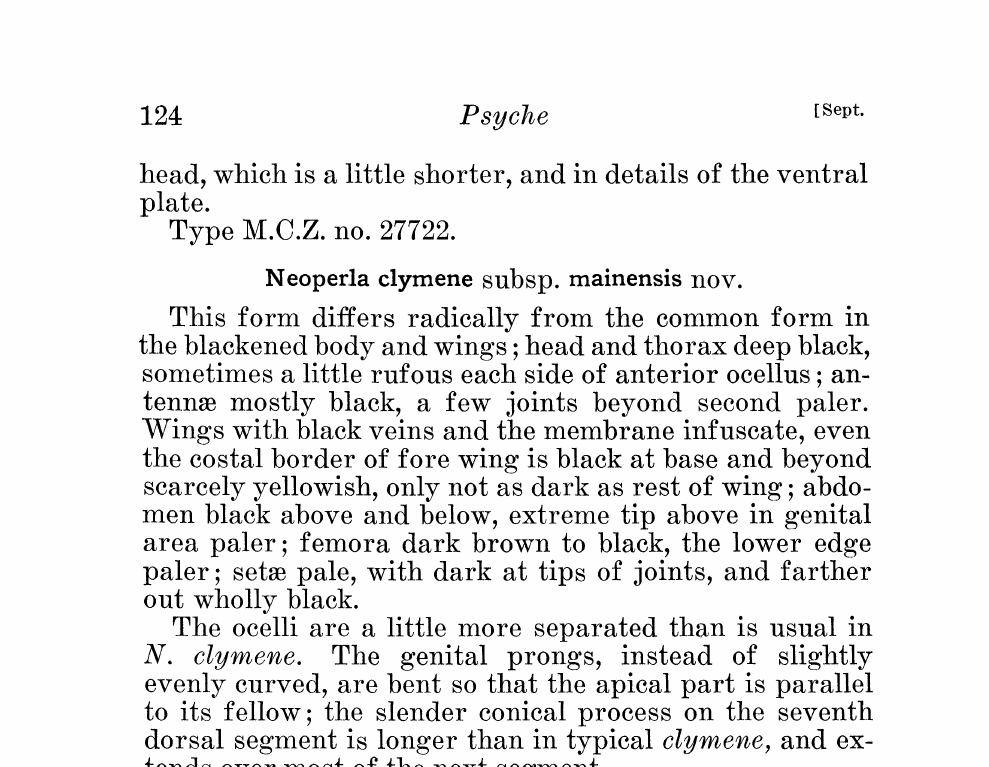
EXPLANATION OF [-)LATE 11 ig. 1. Perlesta decipiens, male genital prongs, and one from side. Fig. 2. Perlesta placida, male genital prongs, and one from side. ig. 3. Perlesta frisoni, female anal plates, and ocellus and boss. Fig. 4. Perlesta frisoni, male genital prongs. texana, tip of abdomen, ocelli, and hind tibia. Fig. 5. Perlesta Fig. 6. Perlesta cinctipes, tip of abdomen, seta, hind femur and tibia. Fig. 7. Perlesta brunneipennis, male genital prongs, and hind tibia. texana, male genital prongs. :Fig. 8. Perlesta Fig. 9. Perlesta cinctipes, male genital prongs. Fig. 10. Perlesta placida, tip of female abdomen from below. Fig. 11. Perlesta frisoni, subgenital plate of female, and ocellus and boss. Fig. 12. Perlesta nitida, subgenital